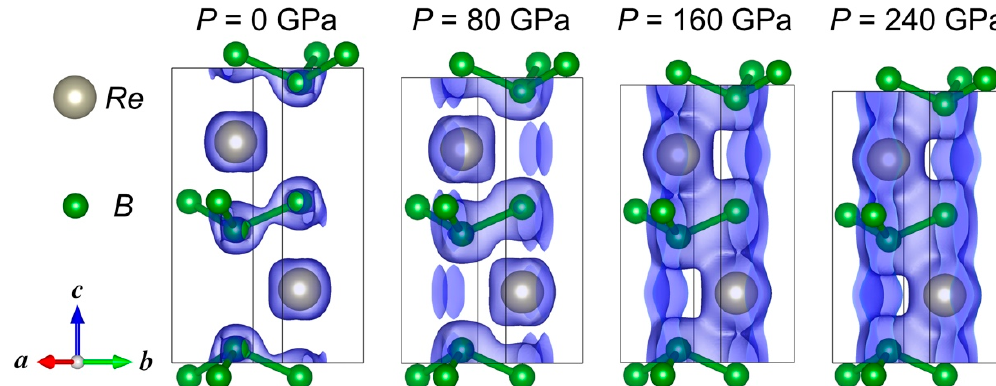
Figure 8. ReB 2 unit cells and iso-surfaces of charge density under external pressures up to 240 GPa. Iso-surface levels were set to be 0.1 a 0 -3 , with a 0 the Bohr radius. The calculations were based on the VASP software and its CHGCAR file, which contains the lattice vectors, atomic coordinates, the total charge density multiplied by the volume on the fine fast Fourier transform-grid, and the projector augmented wave one-center occupancies. The theoretical structural visualization and charge distribution were plotted by the VESTA software.